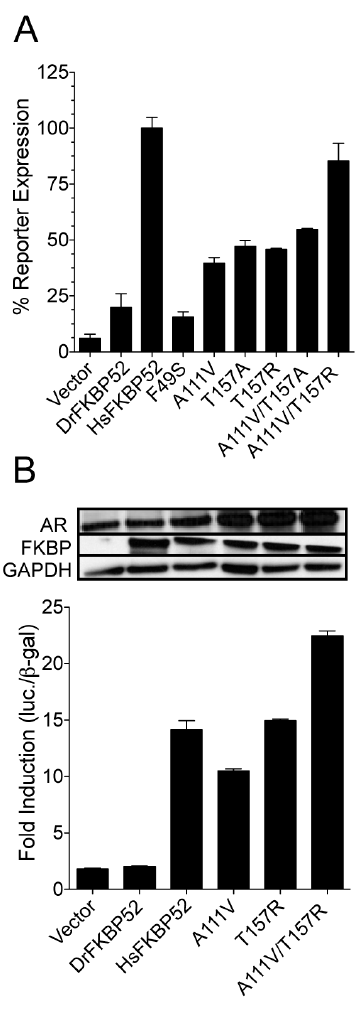
Figure 4. DrFKBP52 mutants potentiate androgen receptor activity. ( A ) Hormone-dependent β -galactosidase reporter gene activity was measured in yeast strains expressing wild type AR in the presence of 3 nM DHT. ( B ) FKBP activities were similarly determined in transfected 52KO MEF cells expressing wild-type AR and a hormone-dependent luciferase reporter. Protein expression levels were monitored by Western blot for the introduced FKBPs, AR, and endogenous GAPDH as a loading control. In all cases (A and B), androgen receptor activity in cells expressing DrFKBP52-A111V / T157R was significantly higher ( p ≤ 0.0001) as compared with cells expressing Vector and DrFKBP52. There was no significant di ff erence in androgen receptor activity in cells expressing human FKBP52 and DrFKBP52-A111V /